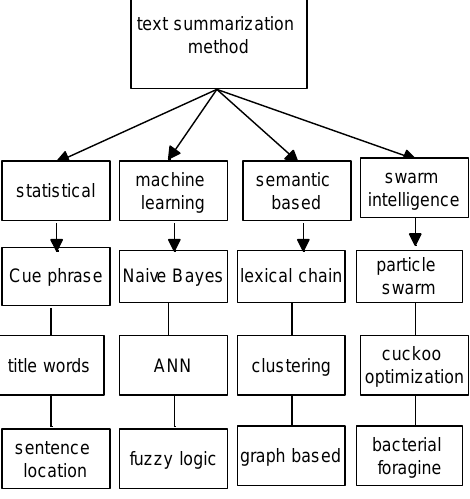
Figure 1: Diagram of text summarization